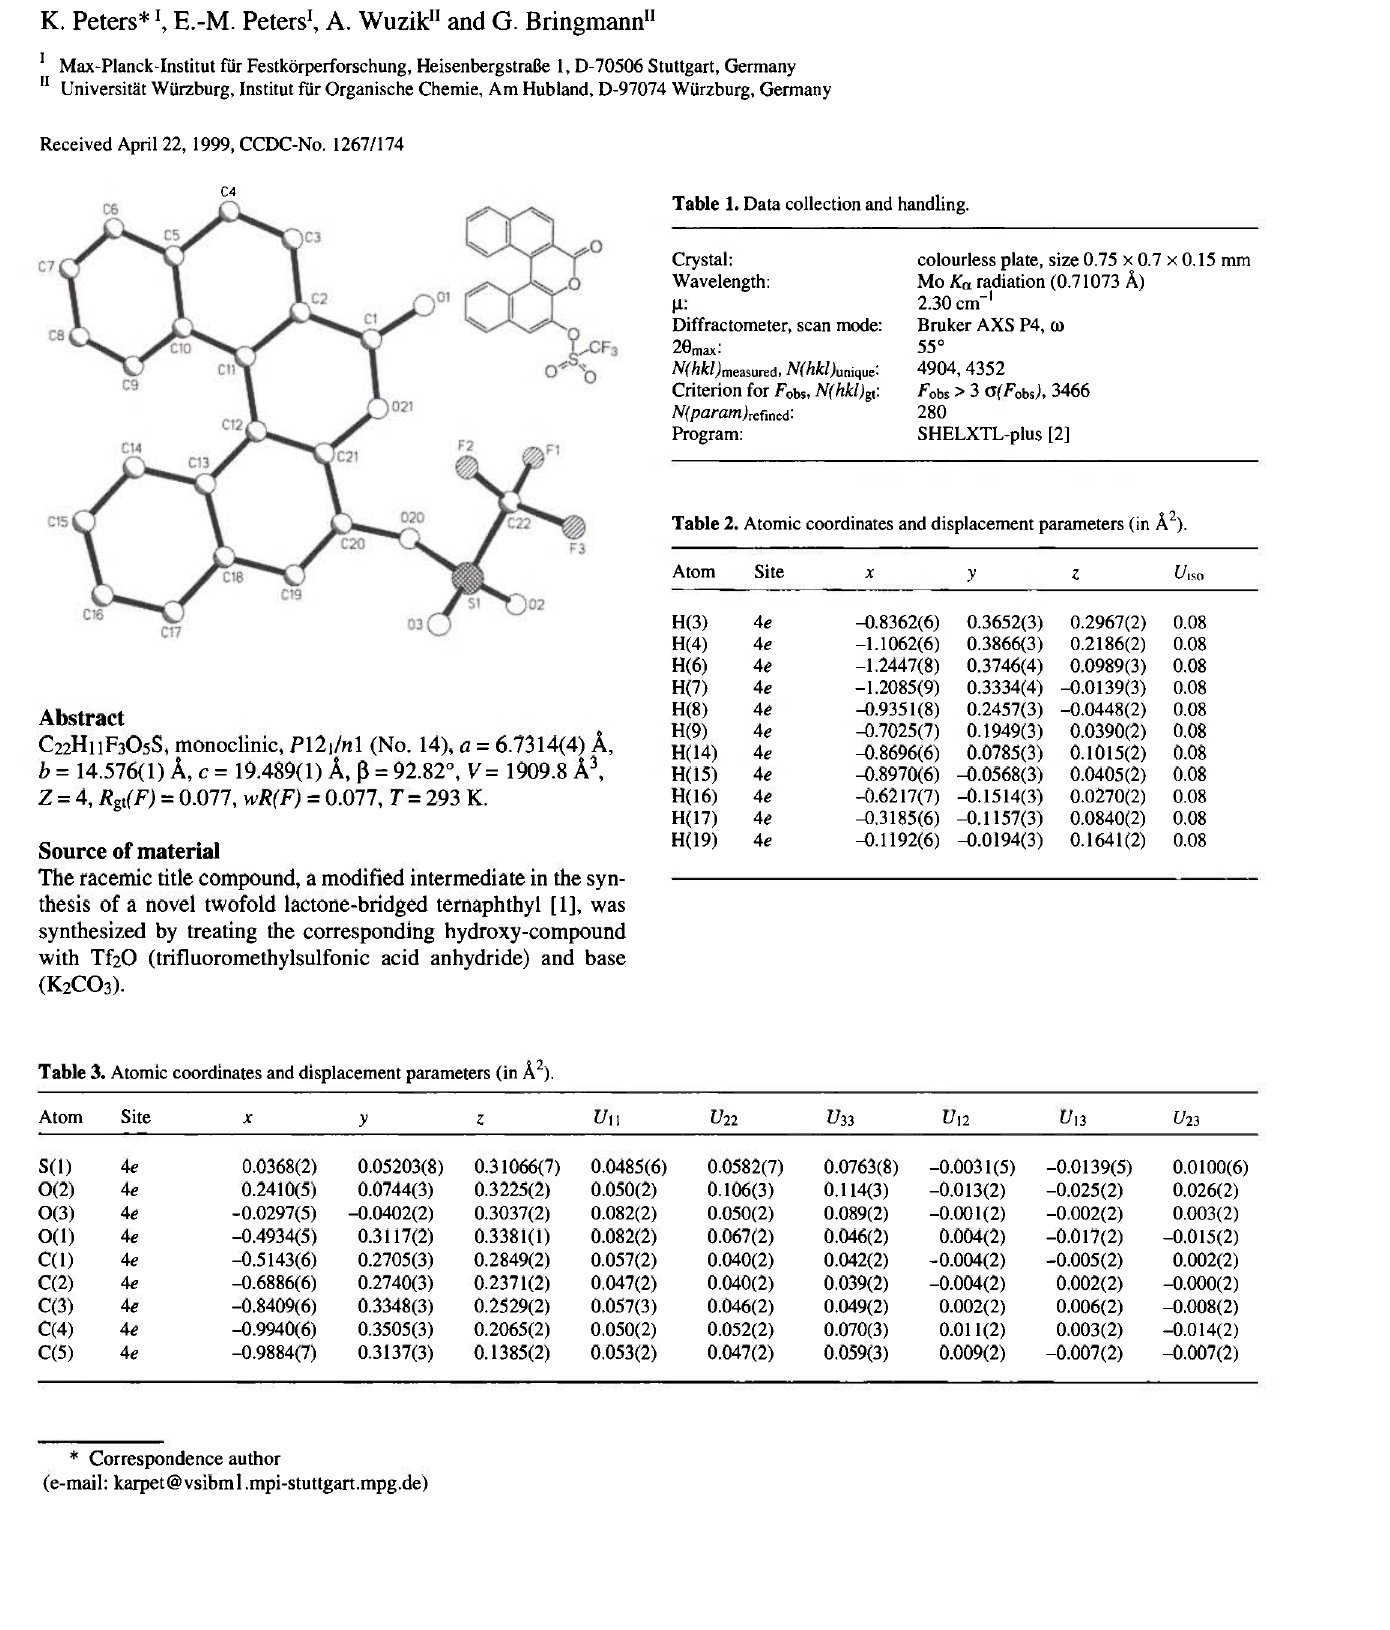
Table 1. Data collection and handling. Crystal: